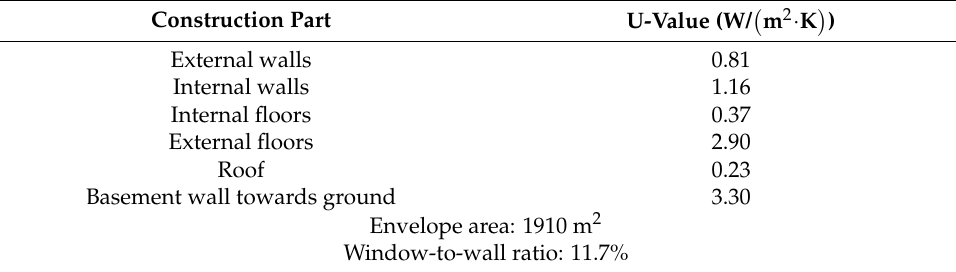
Figure 3. Rådhuset building: ( a ) plan of the first floor; ( b ) photo of south-east-facing façade [2]. Table 1. Thermal transmittance of the building’s construction elements